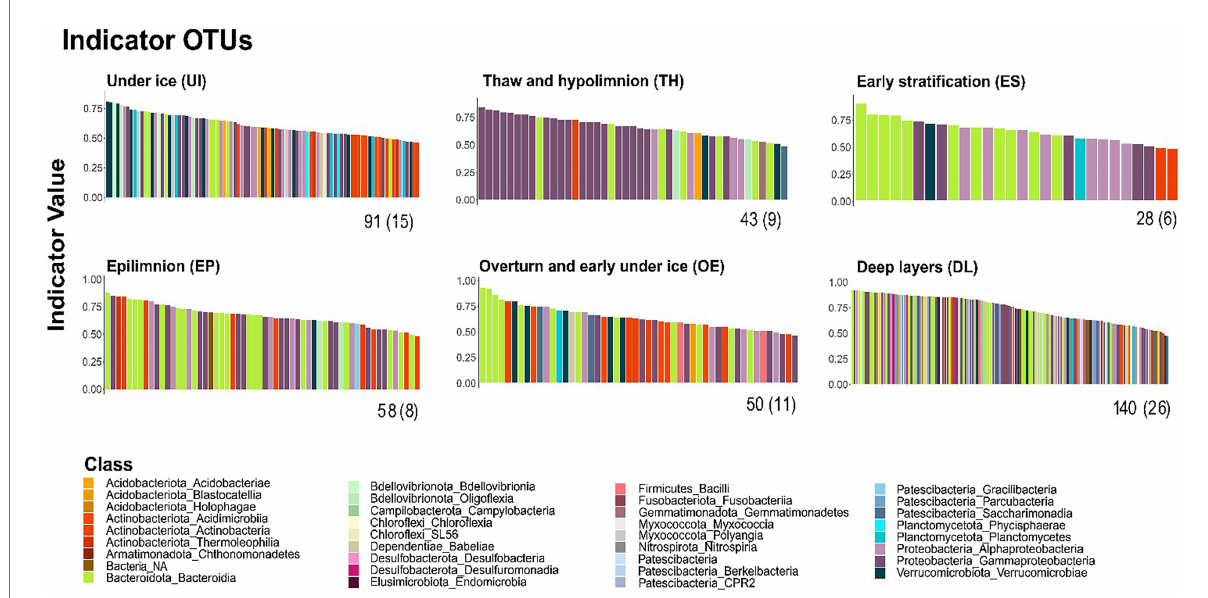
FIGURE 5 Indicator taxa of seasonal clusters. OTUs are ranked according to their significant indicator values. Colors indicate the taxonomic class. The number of indicator OTUs and classes (parenthesis) are indicated below the x